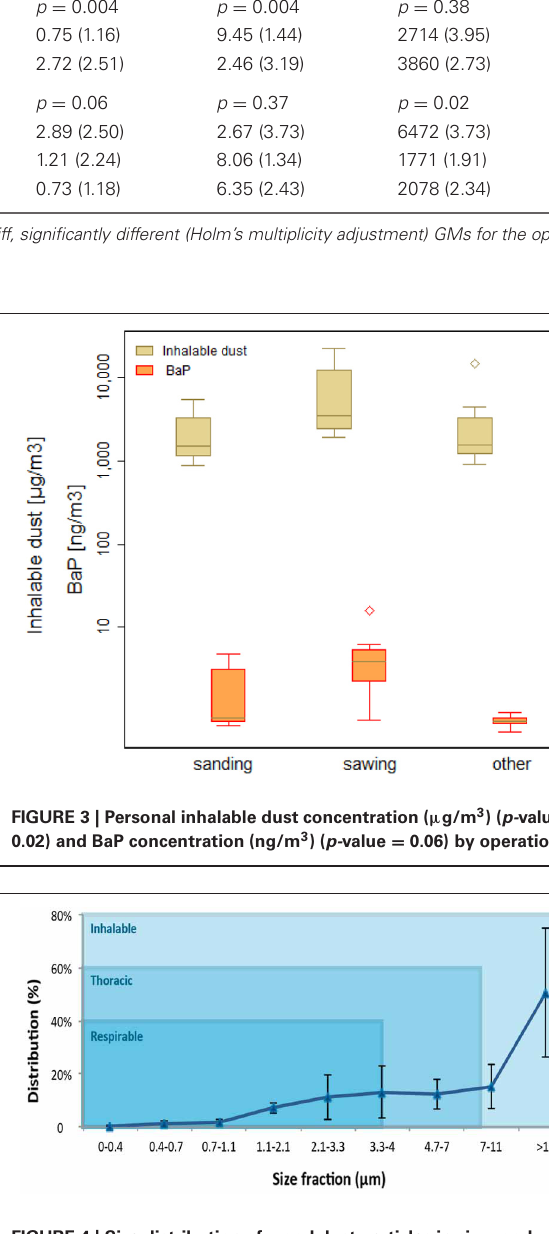
FIGURE 4 | Size distribution of wood dust particles in six wood processing factories (modern and traditional) with cut-off sizes according to a multi-stage cascade